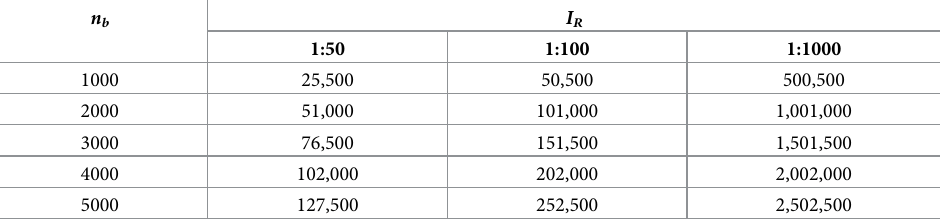
Table 2. Sample size ( n ) of the full dataset generated under each class-imbalance ratio ( I R ) to achieve a target bal- anced sample size ( n b ).